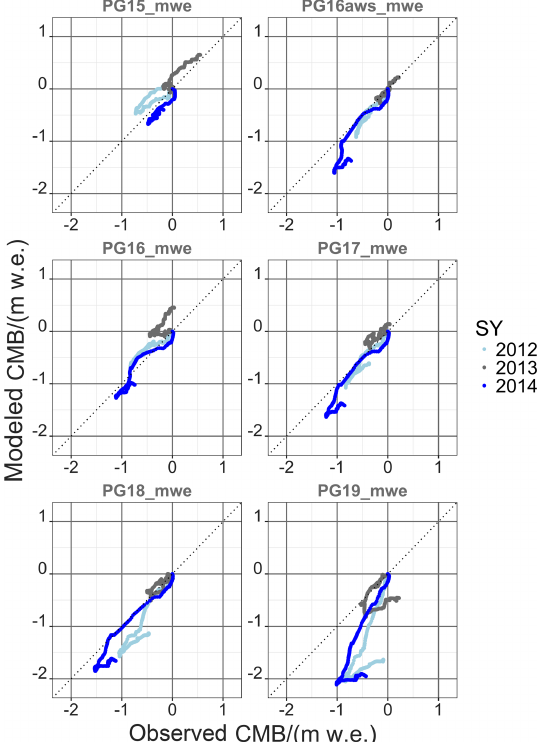
Figure 11. Cumulative mass balance (CMB) from simulations with the glacier melt model (modelled CMB) and observation (observed CMB) on the Warszawa Icefield (transect ID PG1 x ) for validation purposes. Year numbers give the year of start of the glaciological mass balance year. It encompasses the glaciological years 2012/13 to 2014/15.